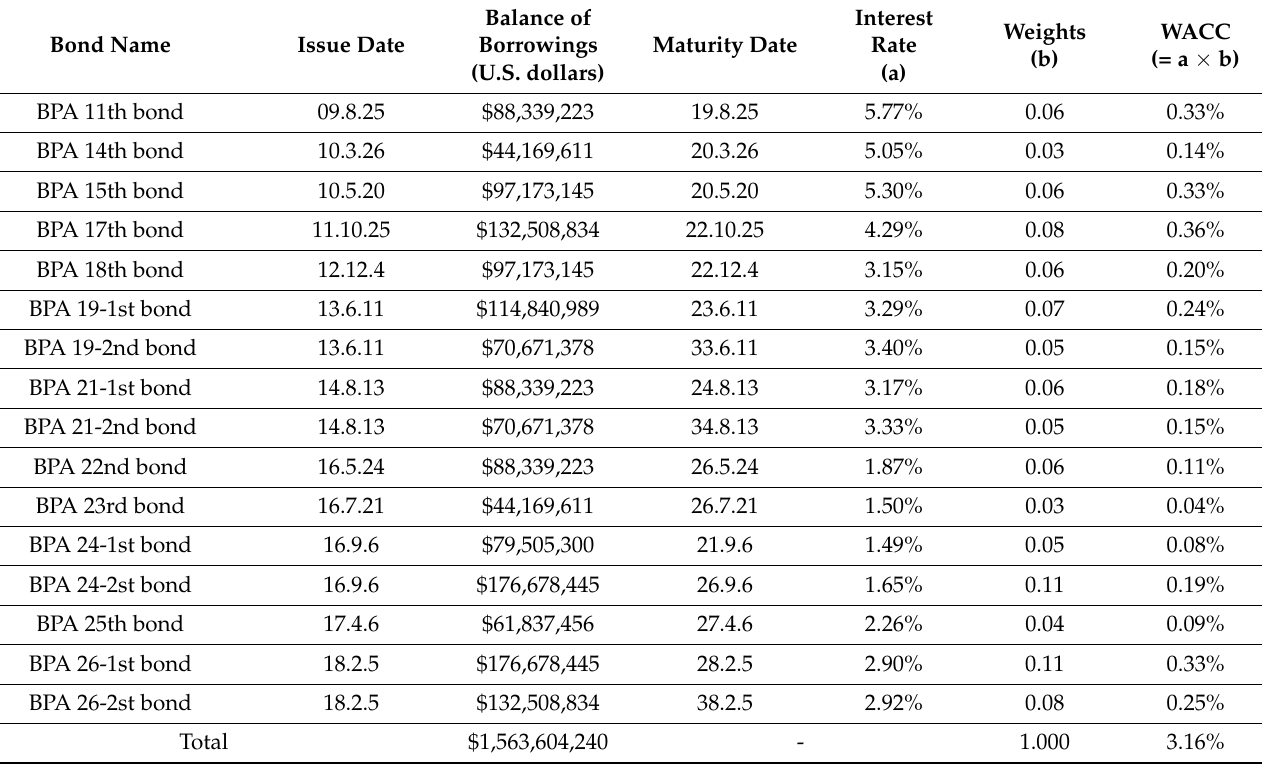
Table 13. Weighted average cost of capital.